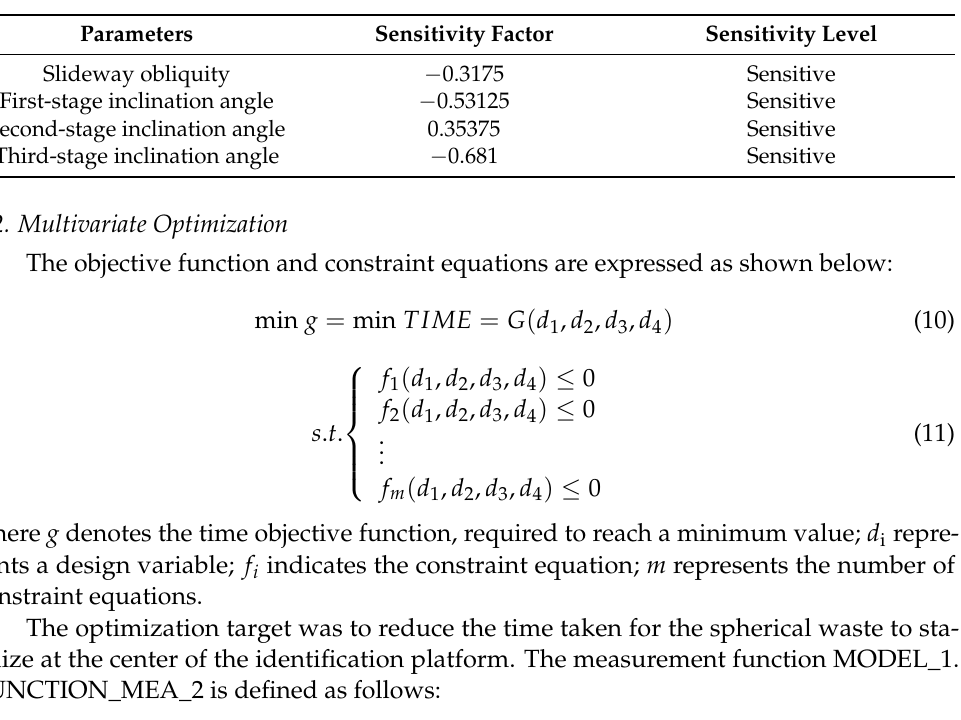
Table 8. Calculated values of sensitivity factors and evaluation of sensitivity level.